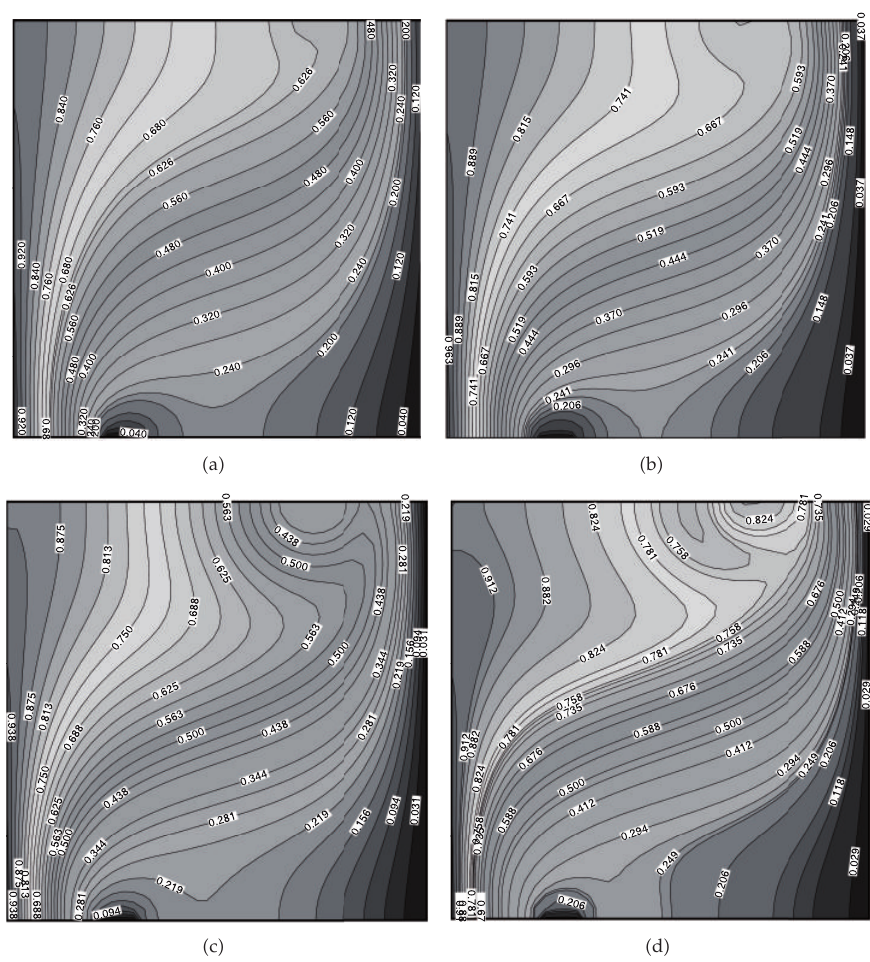
Figure 8: Isoconcentration contours along the left vertical wall while fixing Le (cid:8) 1, B (cid:8) 1, (cid:2) D/H (cid:3) (cid:8) 0 . 1, Ra (cid:8) 100, S C (cid:8) 0 . 1 for (cid:2) a (cid:3) a (cid:8) 0 . 0, (cid:2) b (cid:3) a (cid:8) 0 . 1, (cid:2) c (cid:3) a (cid:8) 0 . 25, (cid:2) d (cid:3) a (cid:8) 0 .